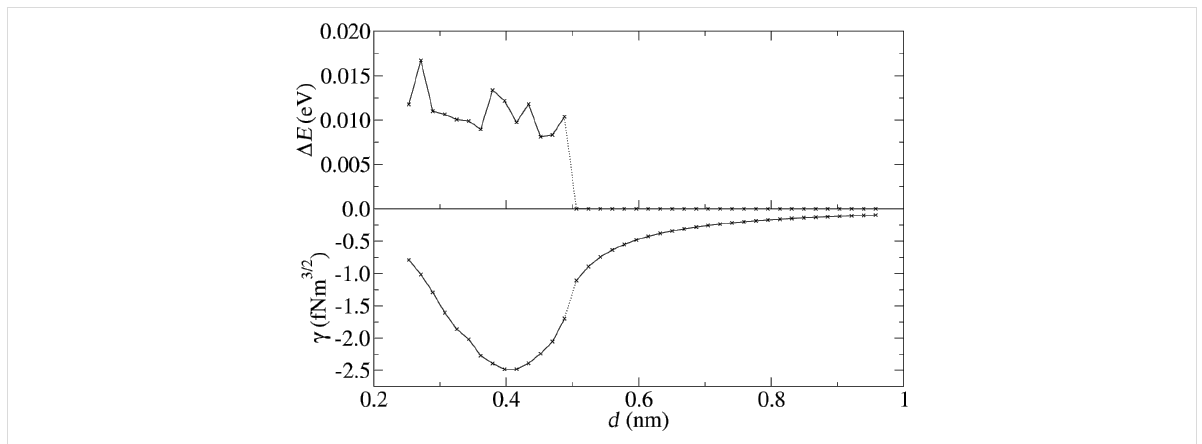
Figure 8: Damping and reduced frequency shift as a function of the nominal distance d for position A (apex atom and projection atom are oppositely charged).